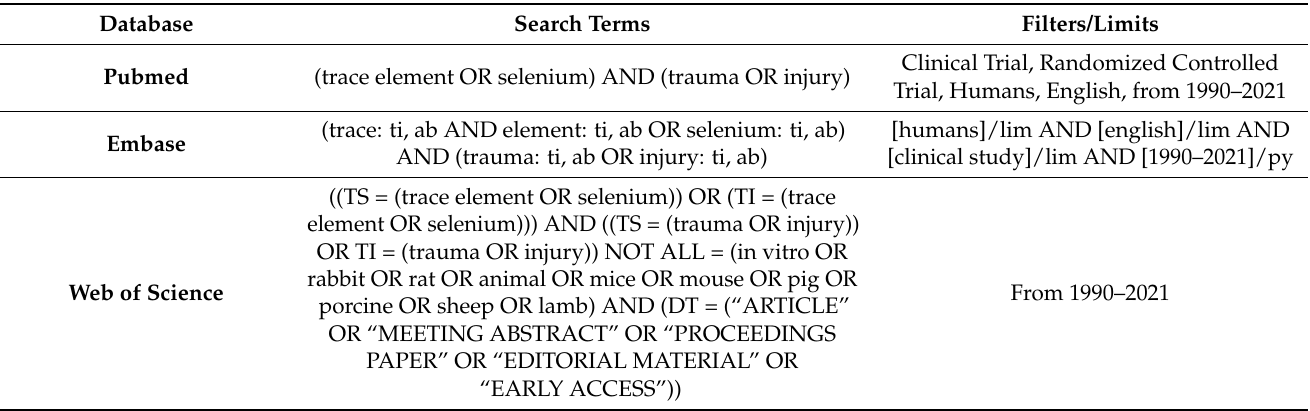
Table 1. Detailed database search strategy including key words and